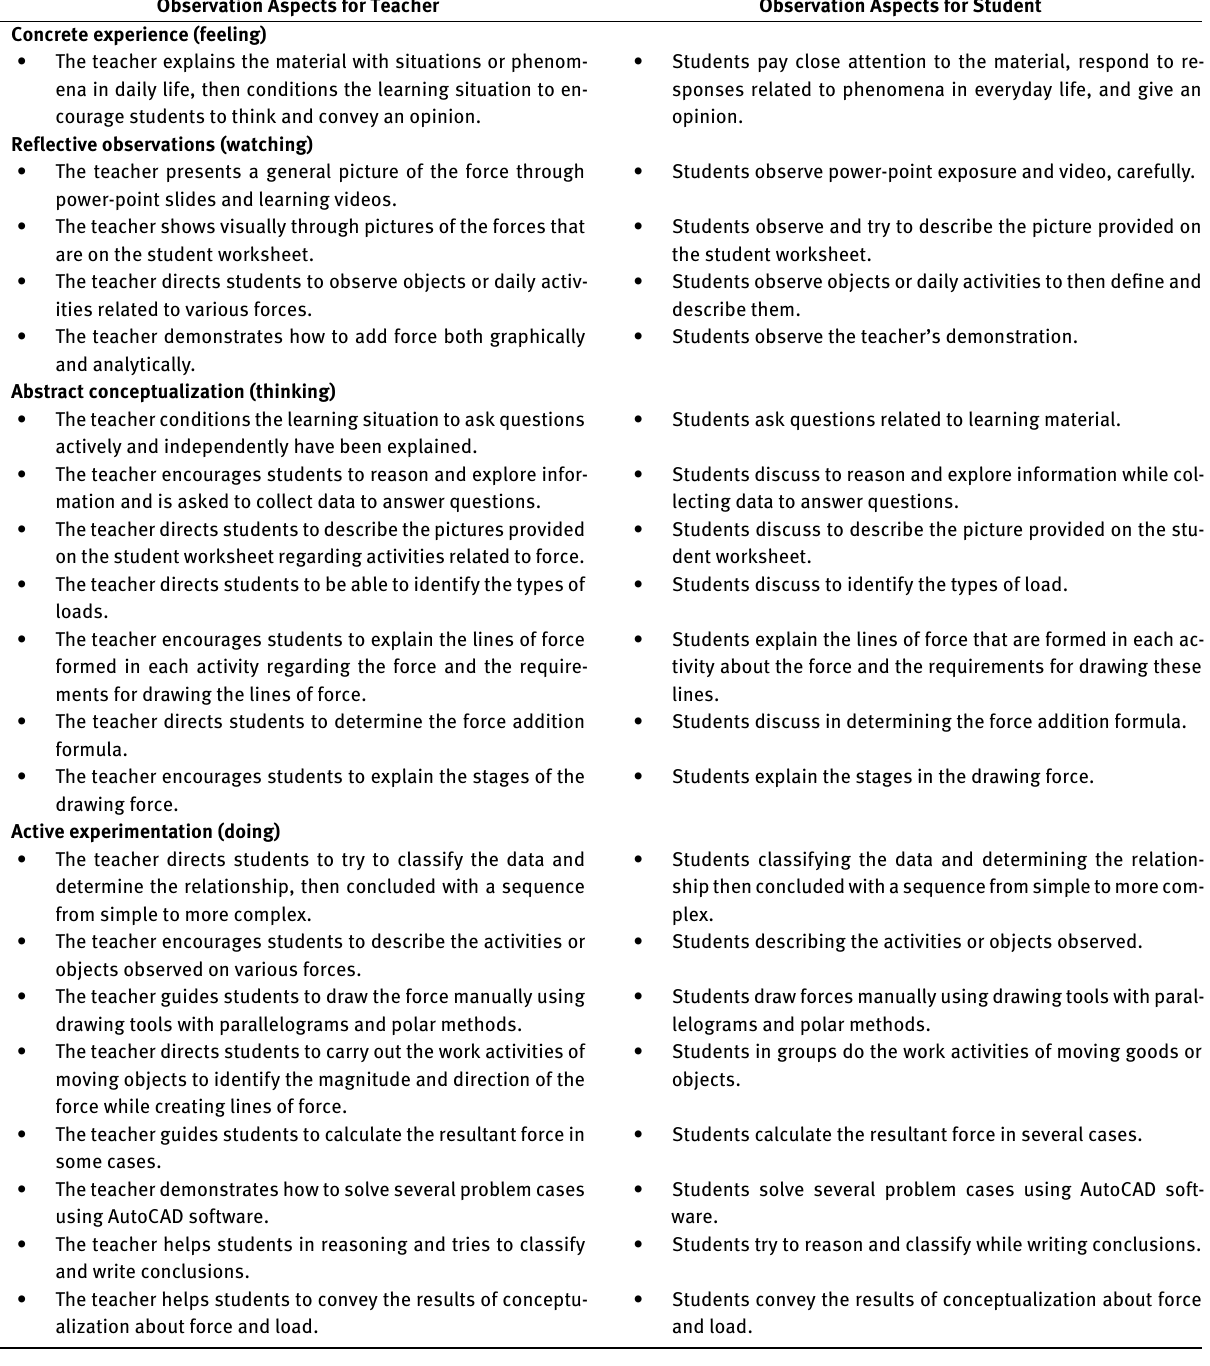
Table 2: Observation checklist the during learning process.